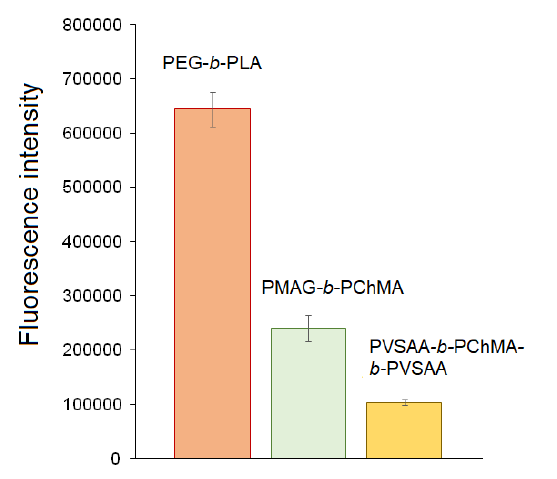
Figure 12. Uptake of the Cy-5 labeled nanoparticles by macrophages. In all cases, the amount of bound Cy5 was 3 µ g/mg of